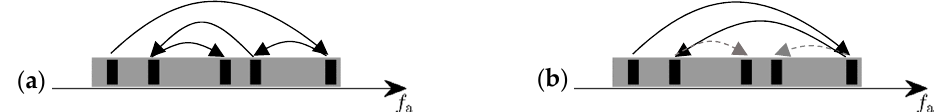
Figure 2. Omission of adjustment steps. The black bars mark a sequence of random ambient vibration frequencies, and the black and grey arrows respectively represent successive and omitted resonance frequency jumps of the energy harvester. ( a ) The harvester tracks the ambient resonance closely, and every possible adjustment step is performed ( r = 1). ( b ) Every other step is omitted ( r = 1/2).